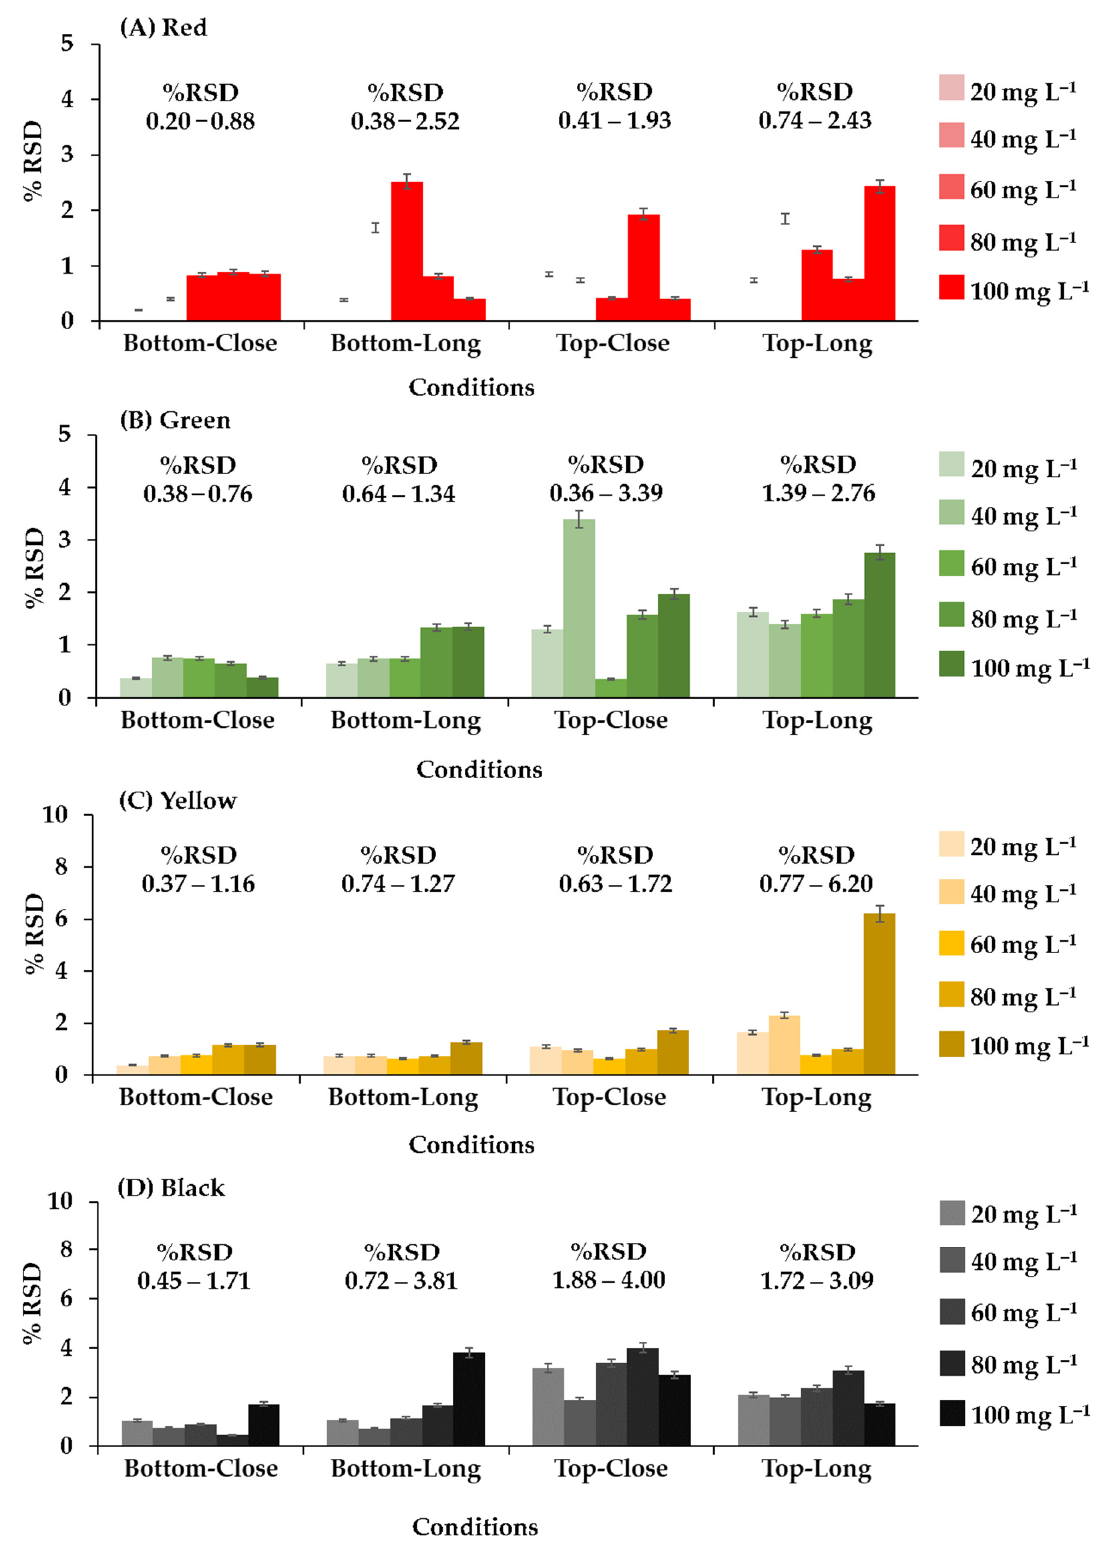
Figure 4. The relative standard deviation of each system configuration from analysis of food coloring; ( A ) red, ( B ) green, ( C ) yellow, and ( D )